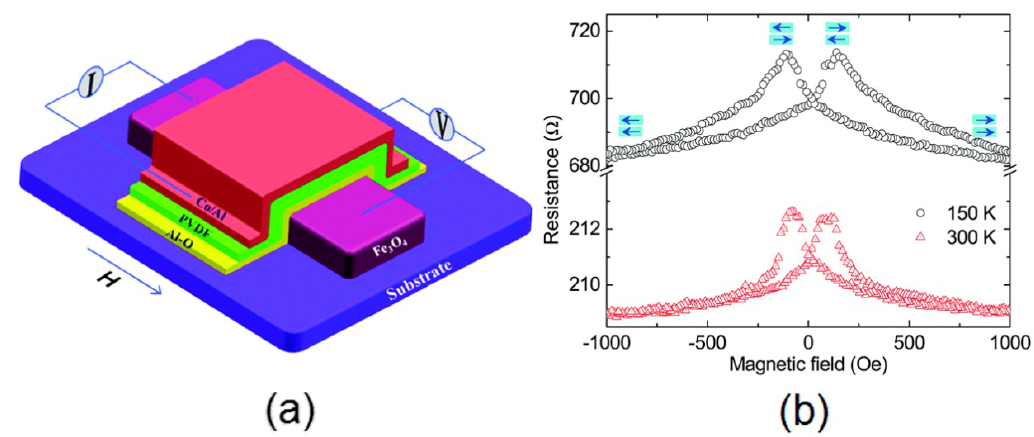
Figure 13. ( a ) Schematic diagram of the spin valve device with an Fe 3 O 4 /AlO/PVDF/Co./Al stacking structure; and ( b ) Magnetoresistance curves for the device at 300 K (red triangles) and 150 K (black circles) [64].